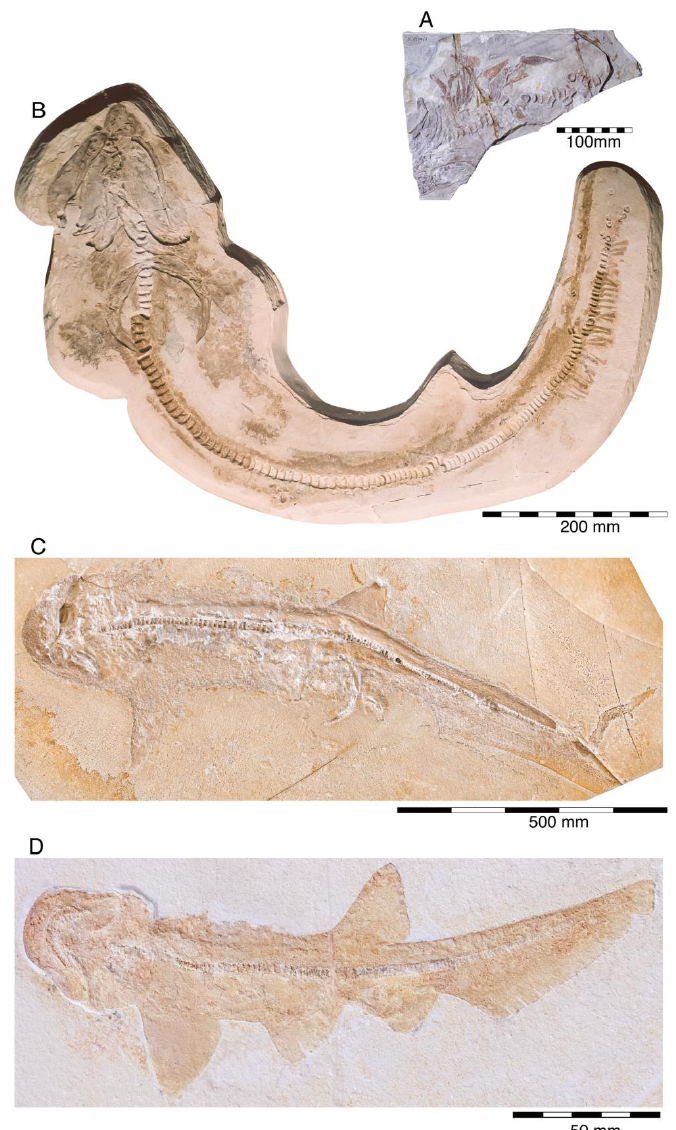
Figure 15. † Paraorthacodus jurensis (Schweizer, 1964 [66]). ( A ) Holotype specimen of † P. jurensis (GPIT 1210/1,) found in the Tithonian of Nusplingen. ( B ) Holomorphic specimen (SMNS 88987-1) found in the Tithonian of Nusplingen. ( C ) Holomorphic specimen (SNSB-BSPG 1964 XXIII 157) from the lower Tithonian of Eichstätt. ( D ) Holomorphic specimen (SNSB-BSPG 1996 I 31) from the lower Tithonian of Eichstätt.